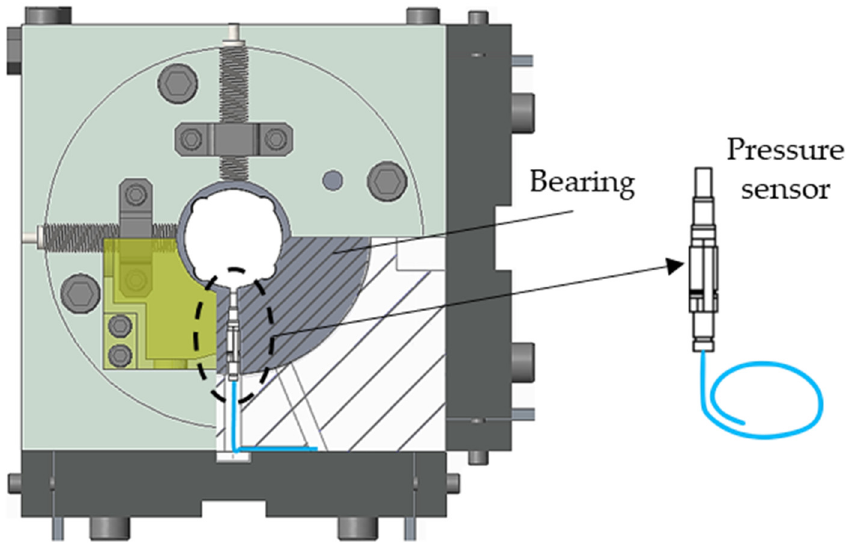
Figure 15. Schematic of the pressure sensor location.